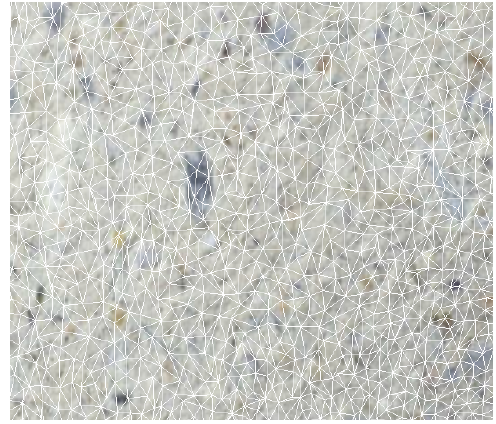
Figure 9: Detail of an UV